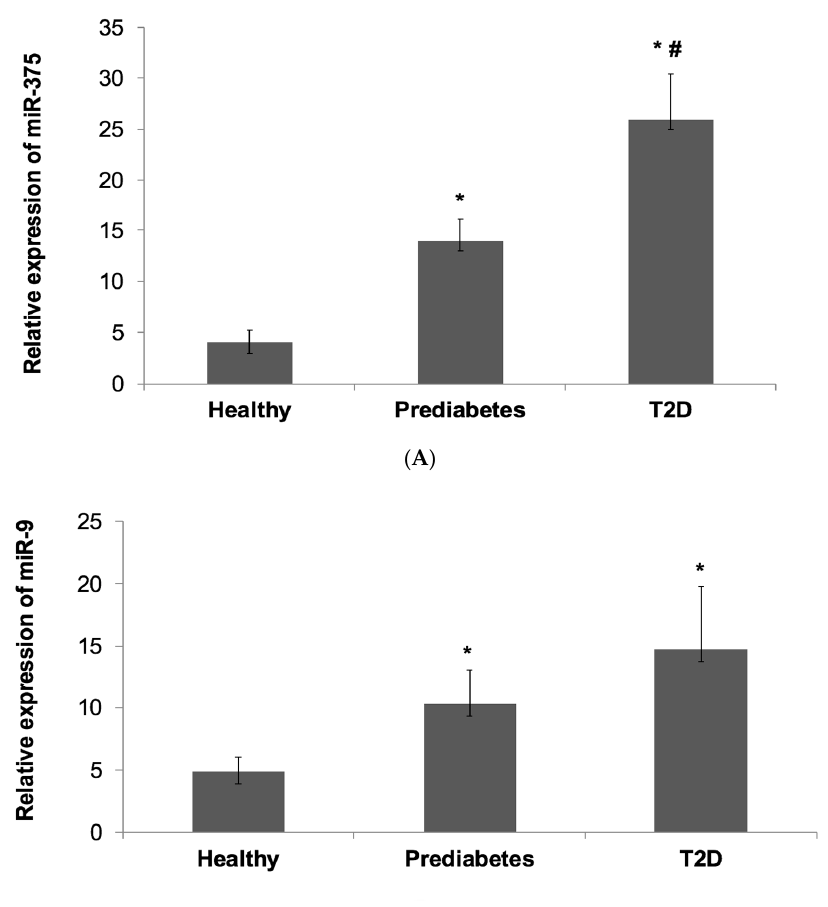
Figure 1. Relative Expression of miR-375 and miR-9 in the Subject Groups. The expression of miR-375 and miR-9 normalization relative to the expression of RNU6B were determined by TaqMan-based RT-qPCR in peripheral whole blood of prediabetes patients, T2D patients and non-diabetic healthy control individuals. ( A ): miR-375. ( B ): miR-9. Data is shown as mean ± SD. * p < 0.05 compared to healthy controls. # p < 0.05 compared to prediabetes.